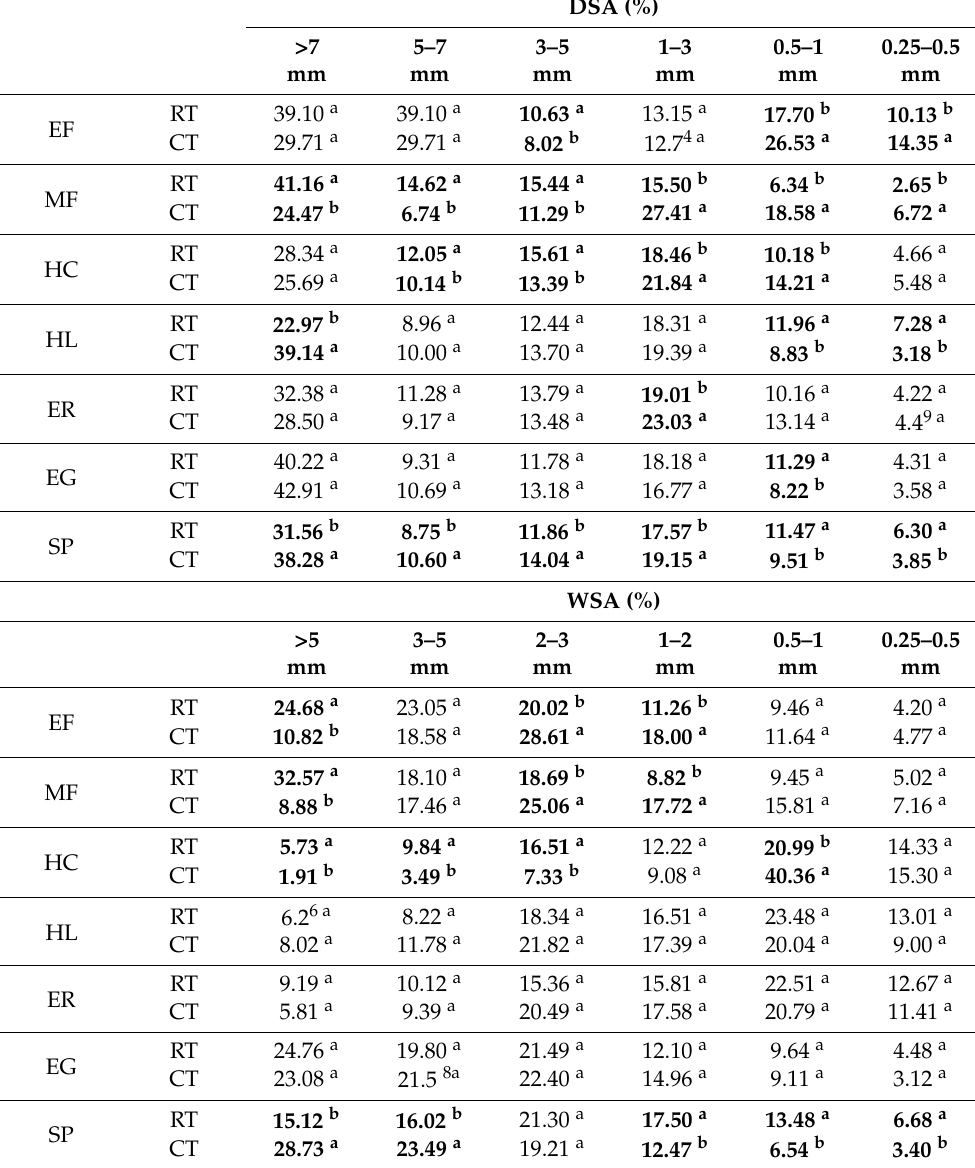
Table 3. Differences in the fractions of soil macroaggregates of different soils and